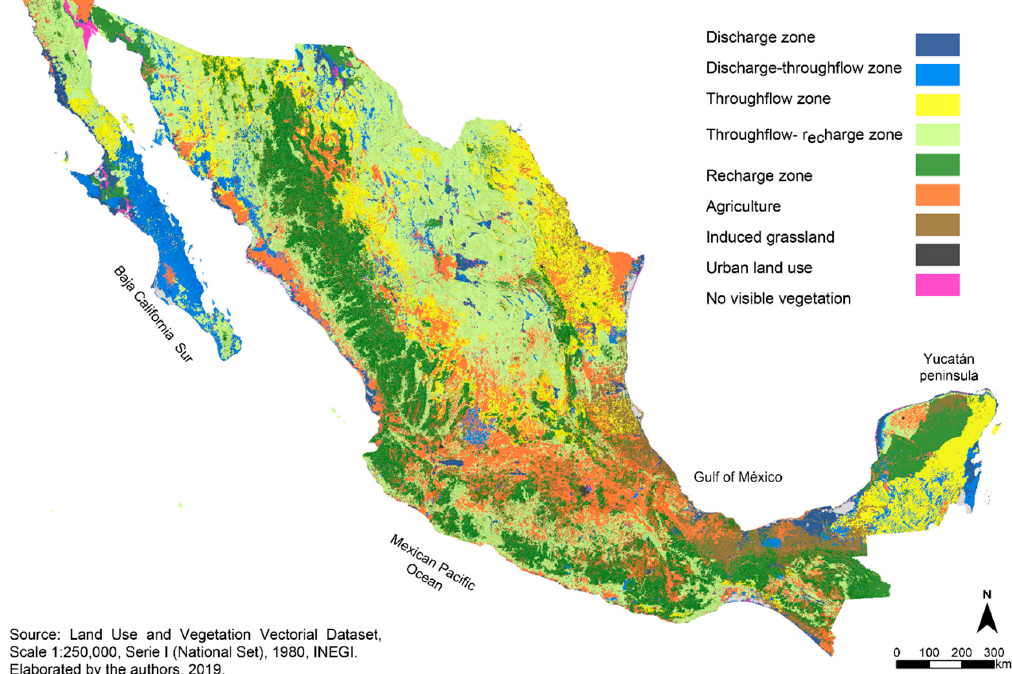
Figure 6. Association of hydrogeological features with vegetation and land use.